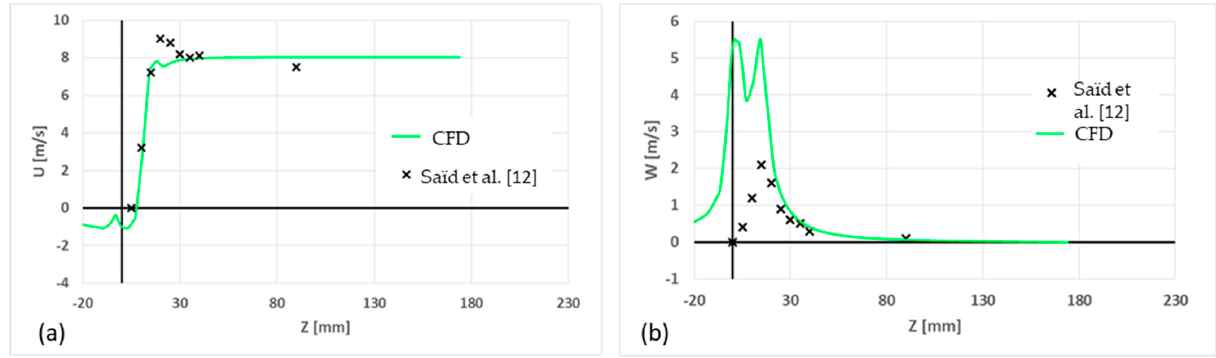
Figure 4. Flow velocity components at section x = 8 [mm]—( a ) U component and ( b ) W component [12].